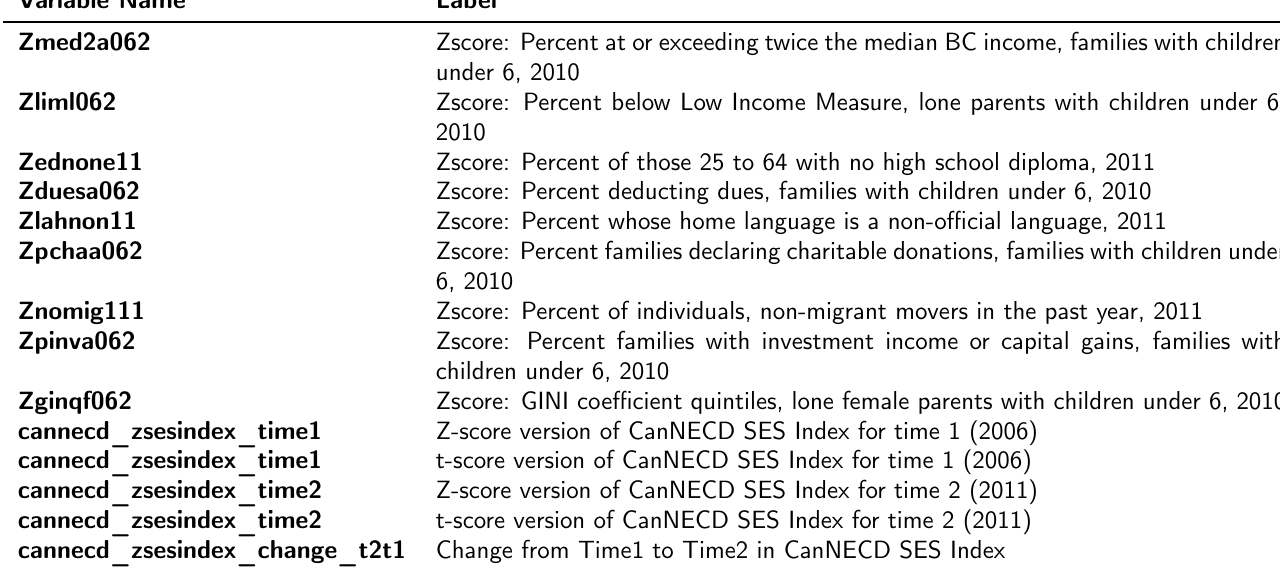
Supplemental Table 1. cont. Early Development Instrument Variables in the CanNECD Database Variable